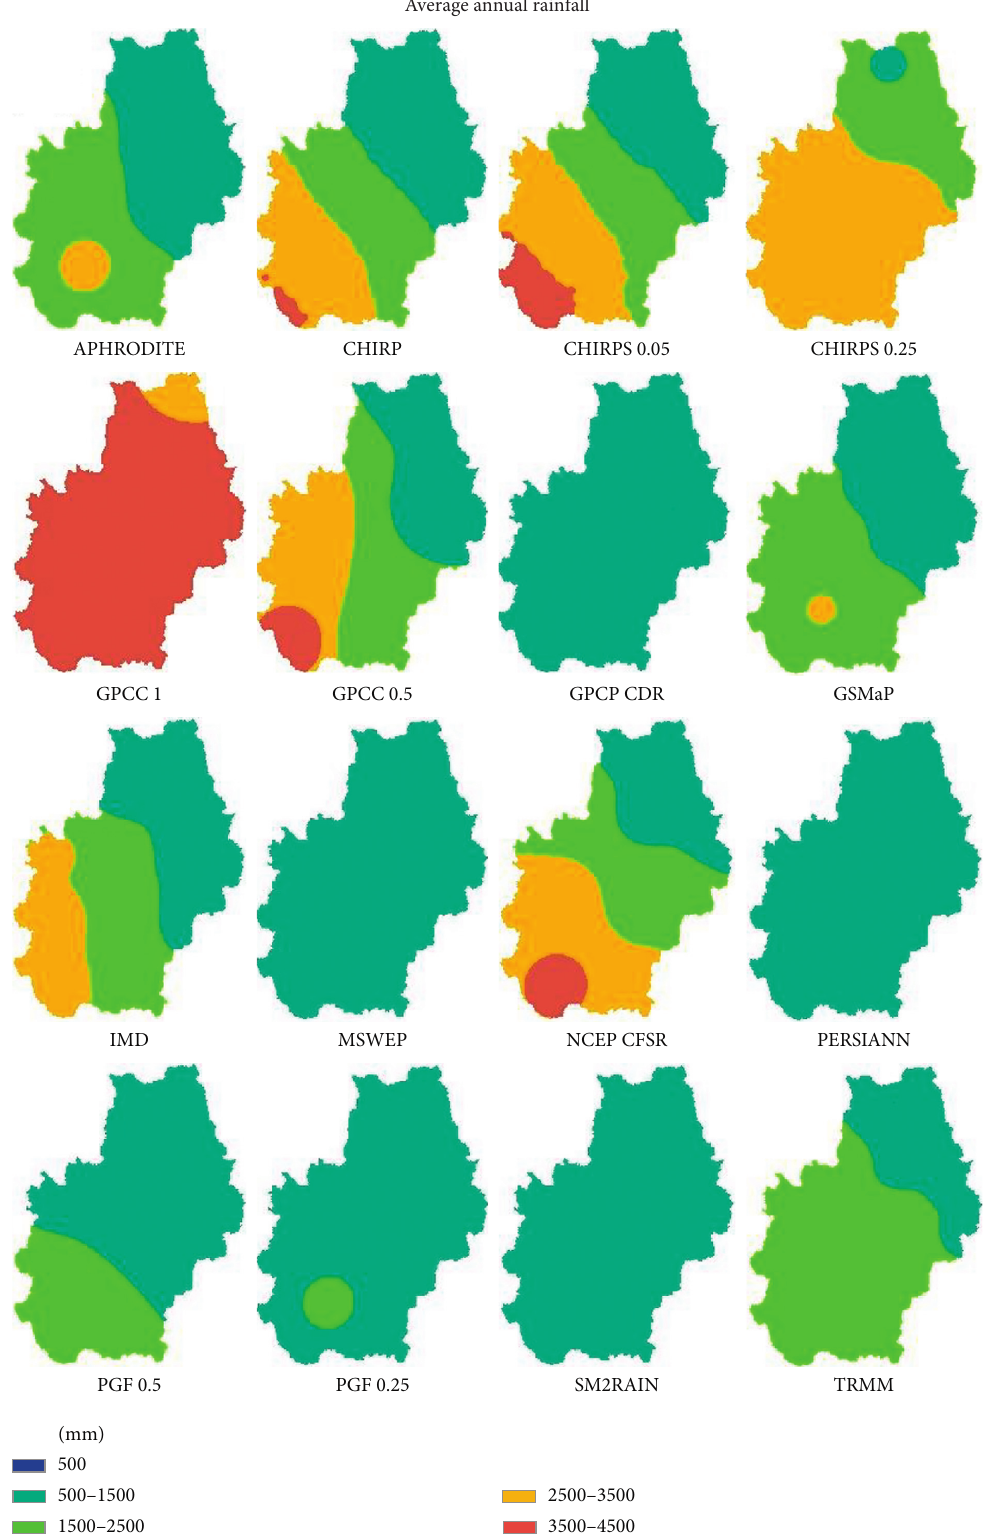
Figure 3: Spatial variations of the thirteen-year mean annual precipitation of sixteen rainfall